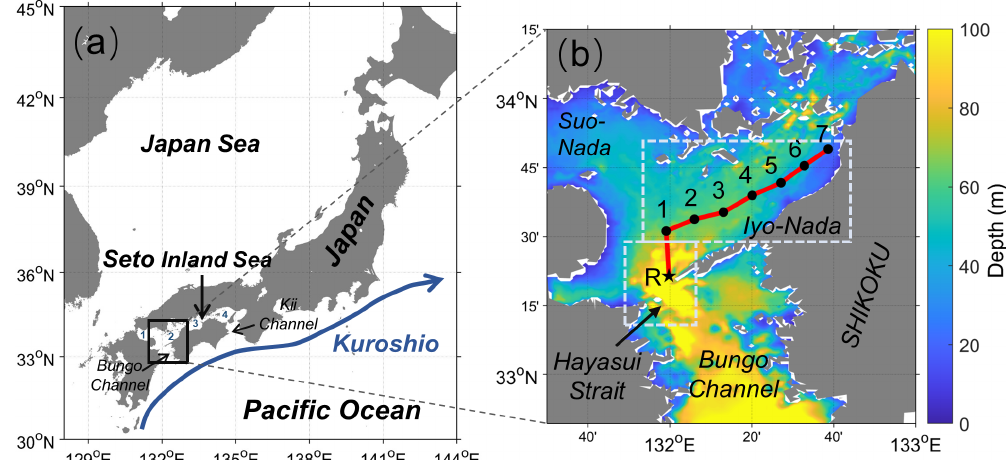
Figure 1. Location of (a) Seto Inland Sea and (b) observation stations. The numbers from 1 to 4 in (a) represent Suo-Nada, Iyo-Nada, Hiuchi-Nada, and Harima-Nada, respectively. Observation stations are represented by black dots and stars. The areas enclosed in the dotted boxes in (b) represent Iyo-Nada (33.45–33.75 ◦ N, 131.9–132.8 ◦ E) and the Hayasui Strait (33.15–33.45 ◦ N, 131.8–132.1 ◦ E), which were used in the numerical sensitivity